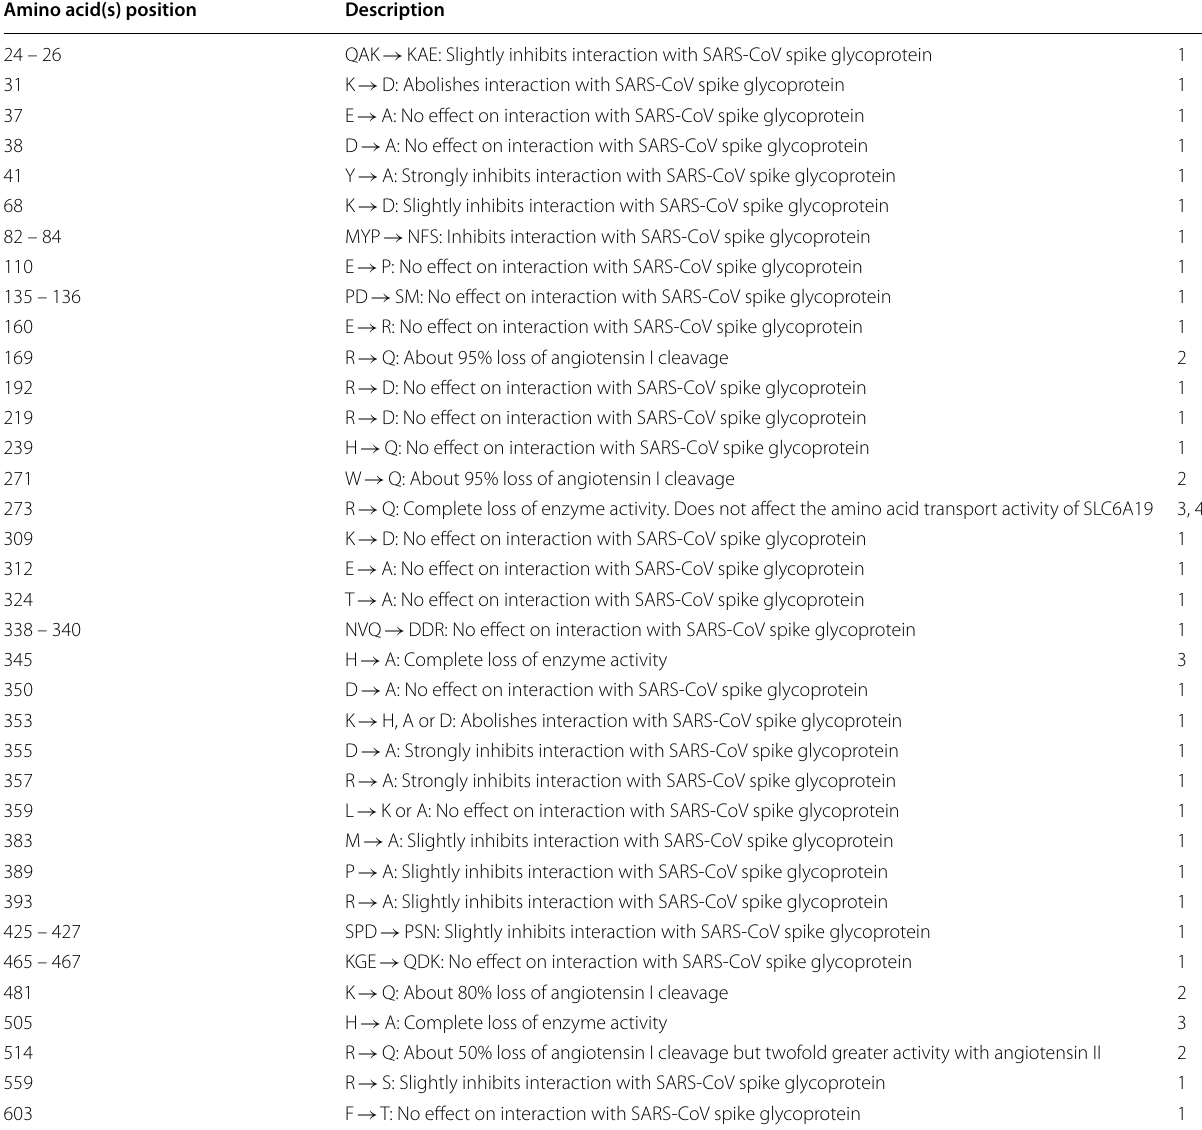
Table 1 Effect of the experimental mutation of one or more amino acid(s) of ACE2 on the biological properties of the protein Amino acid(s) position